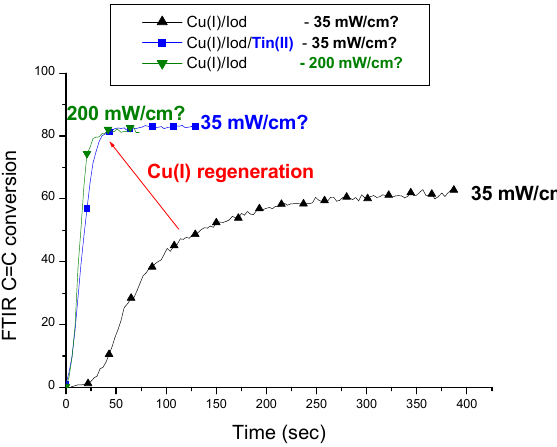
Figure 16. Polymerization profiles of the mixture of monomers by varying the light intensity upon irradiation with a LED@405 nm under air, 1.4 mm thick samples. Reproduced with permission from the authors of [28]. Copyright 2017 American Chemical Society.